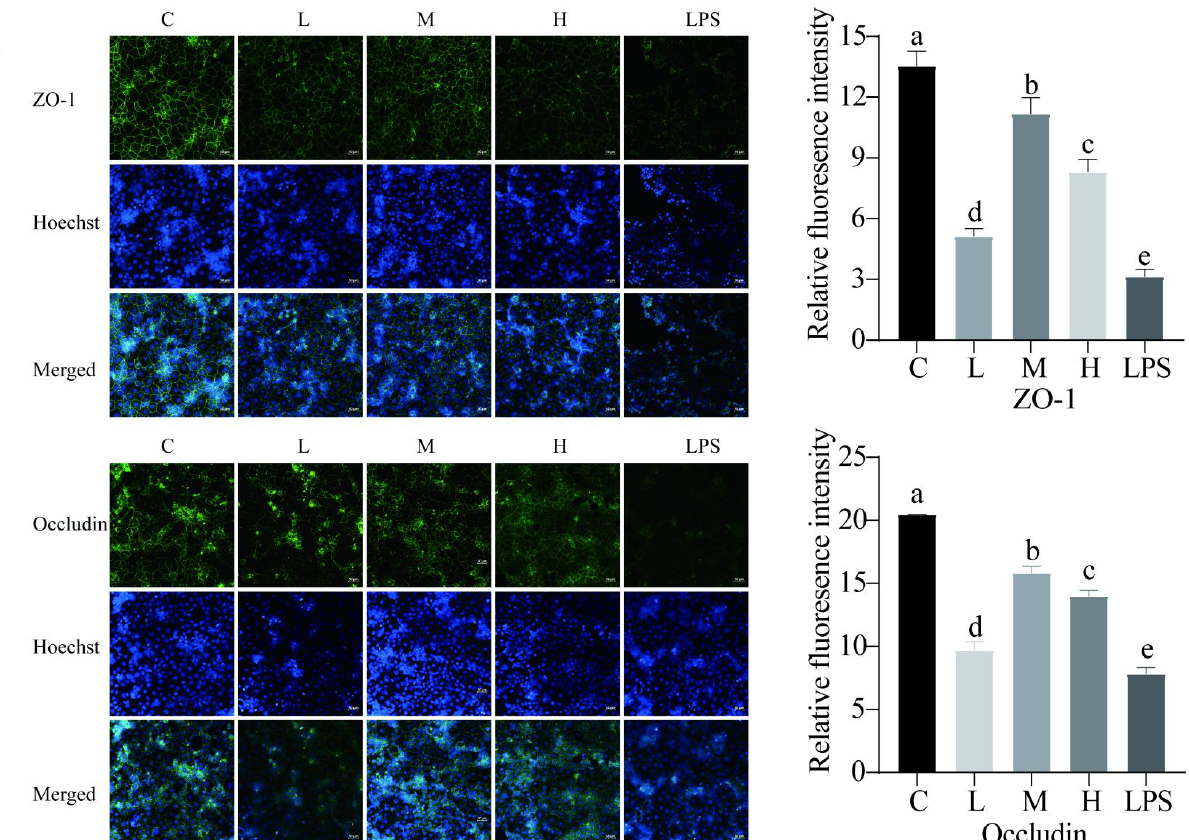
Figure 6. Effects of L. rhamnosus CY12 on immunolocalization and the relative fluorescence intensity of tight junction proteins in LPS-induced Caco-2 Cells. ( A ). ZO-1. ( B ). Occludin. Note: C represents uninduced Caco-2 cells; L, M, and H represent LPS-induced Caco-2 cells co-incubated with 10 7 , 10 8 and 10 9 cfu/mL L. rhamnosus CY12, respectively; LPS represents LPS-induced Caco-2 cells. Data were presented as mean ± SEM. Means with the different letters are significantly different p < 0.05. The magnification of these picture is 100X, and scale bar is 50 µm.